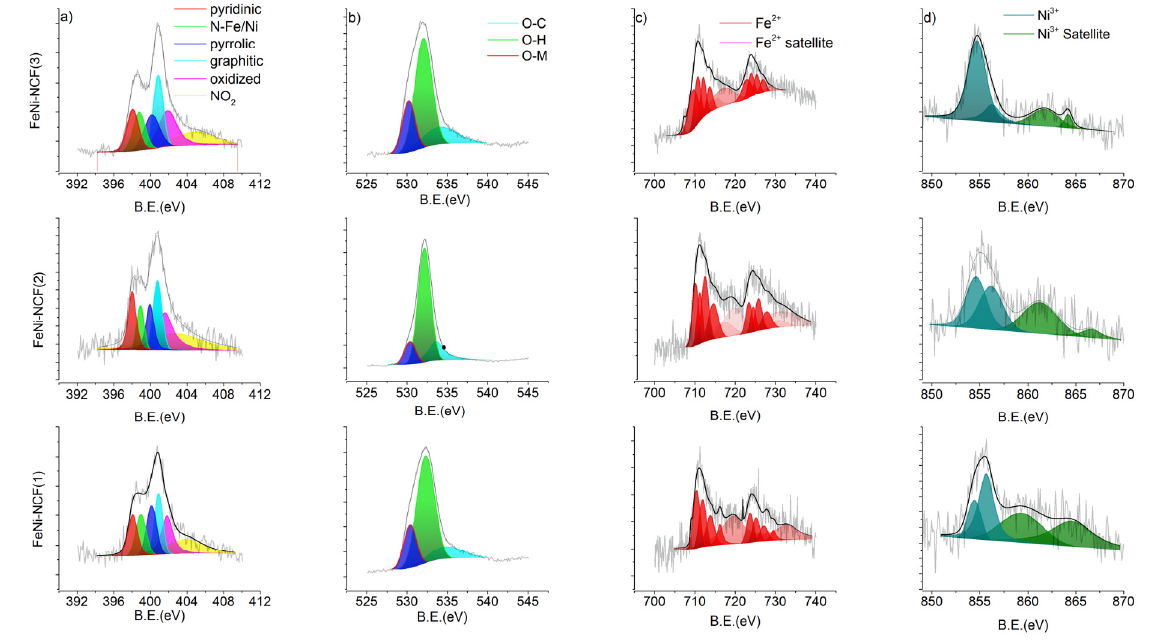
Figure 3. High-resolution XPS spectra of the FeNi-NCF samples: ( a ) N 1s, ( b ) O 1s, ( c ) Fe 2p, and ( d ) Ni 2p.